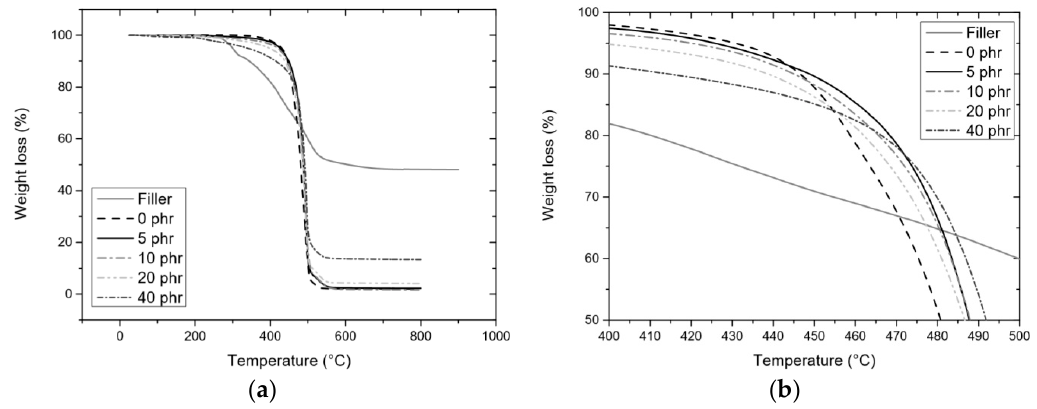
Figure 5. Thermal Gravimetric Analysis (TGA) curves of POSS ‐ A filler and F TA nanocomposites at different filler loading under air. ( a ) unzoomed; ( b ) zoomed.